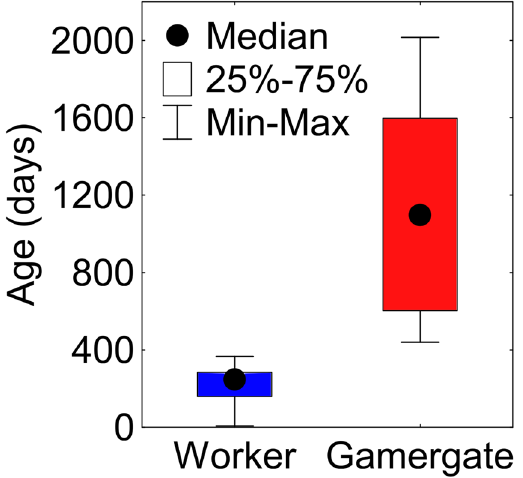
Figure 3. Longevity of H . saltator females and reproductive status. Differential longevity of gamergates (N = 55) and non-reproductive workers (N = 61) of H . saltator (t-test, t = 13.4, df = 114, p < 0.00001, data of 21 non-reproductive worker samples were also used in Haight, 2012 43